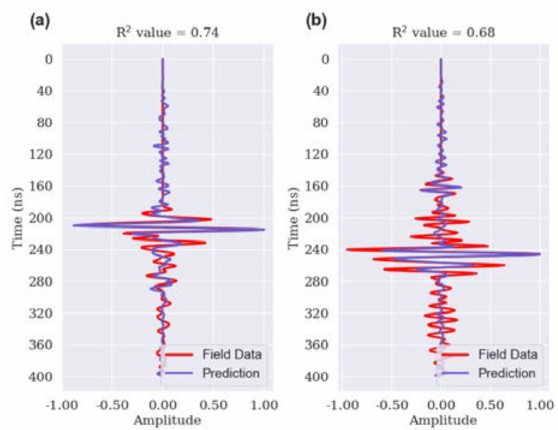
Figure 14. ( a ) The matching result for GPR traces picked up from Figure 12a,b at 2.53 m offset. ( b ) The matching result for GPR traces picked up from Figure 12a,b at 13.32 m offset.